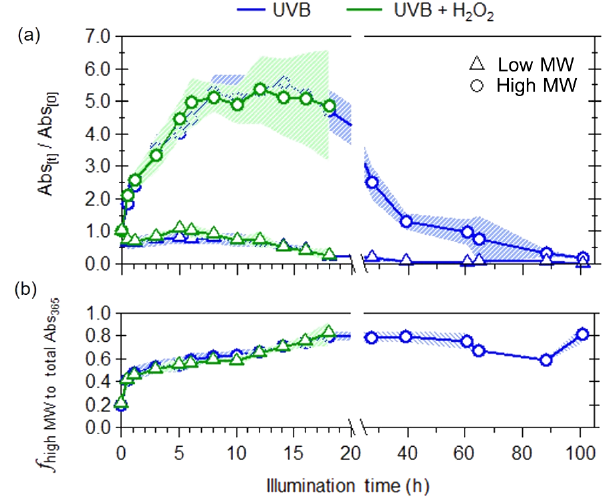
Figure 3. Changes in (a) light absorption at a wavelength of 365nm for low-MW (triangles) and high-MW (circles) BrC fractions and (b) contribution of high-MW fraction to total light absorbance at 365nm in WS smoke BrC due to UVB photolysis (blue) and aque- ous OH oxidation (green). The shaded areas represent the variability ( ± 1 σ ) in multiple experiments ( n =